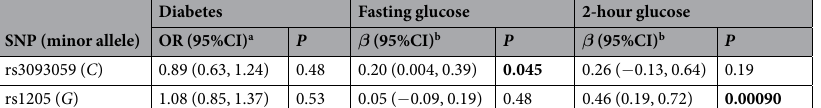
SNP (minor allele) rs1205 ( G ) 1.08 (0.85, 1.37) Table 5. Association of minor allele of the CRP-associated SNPs with diabetes prevalence and levels of fasting and 2-hour glucose. a The association was adjusted for gender, age, BMI, waist, SBP, DBP, hypertension, CVD, CHOL, HDL, TG, physical activity, smoking, and alcohol drinking. b The association was adjusted for gender, age, BMI, waist, SBP, DBP, hypertension, CVD, CHOL, HDL, TG, physical activity, smoking, alcohol drinking, and the use of medications for treating